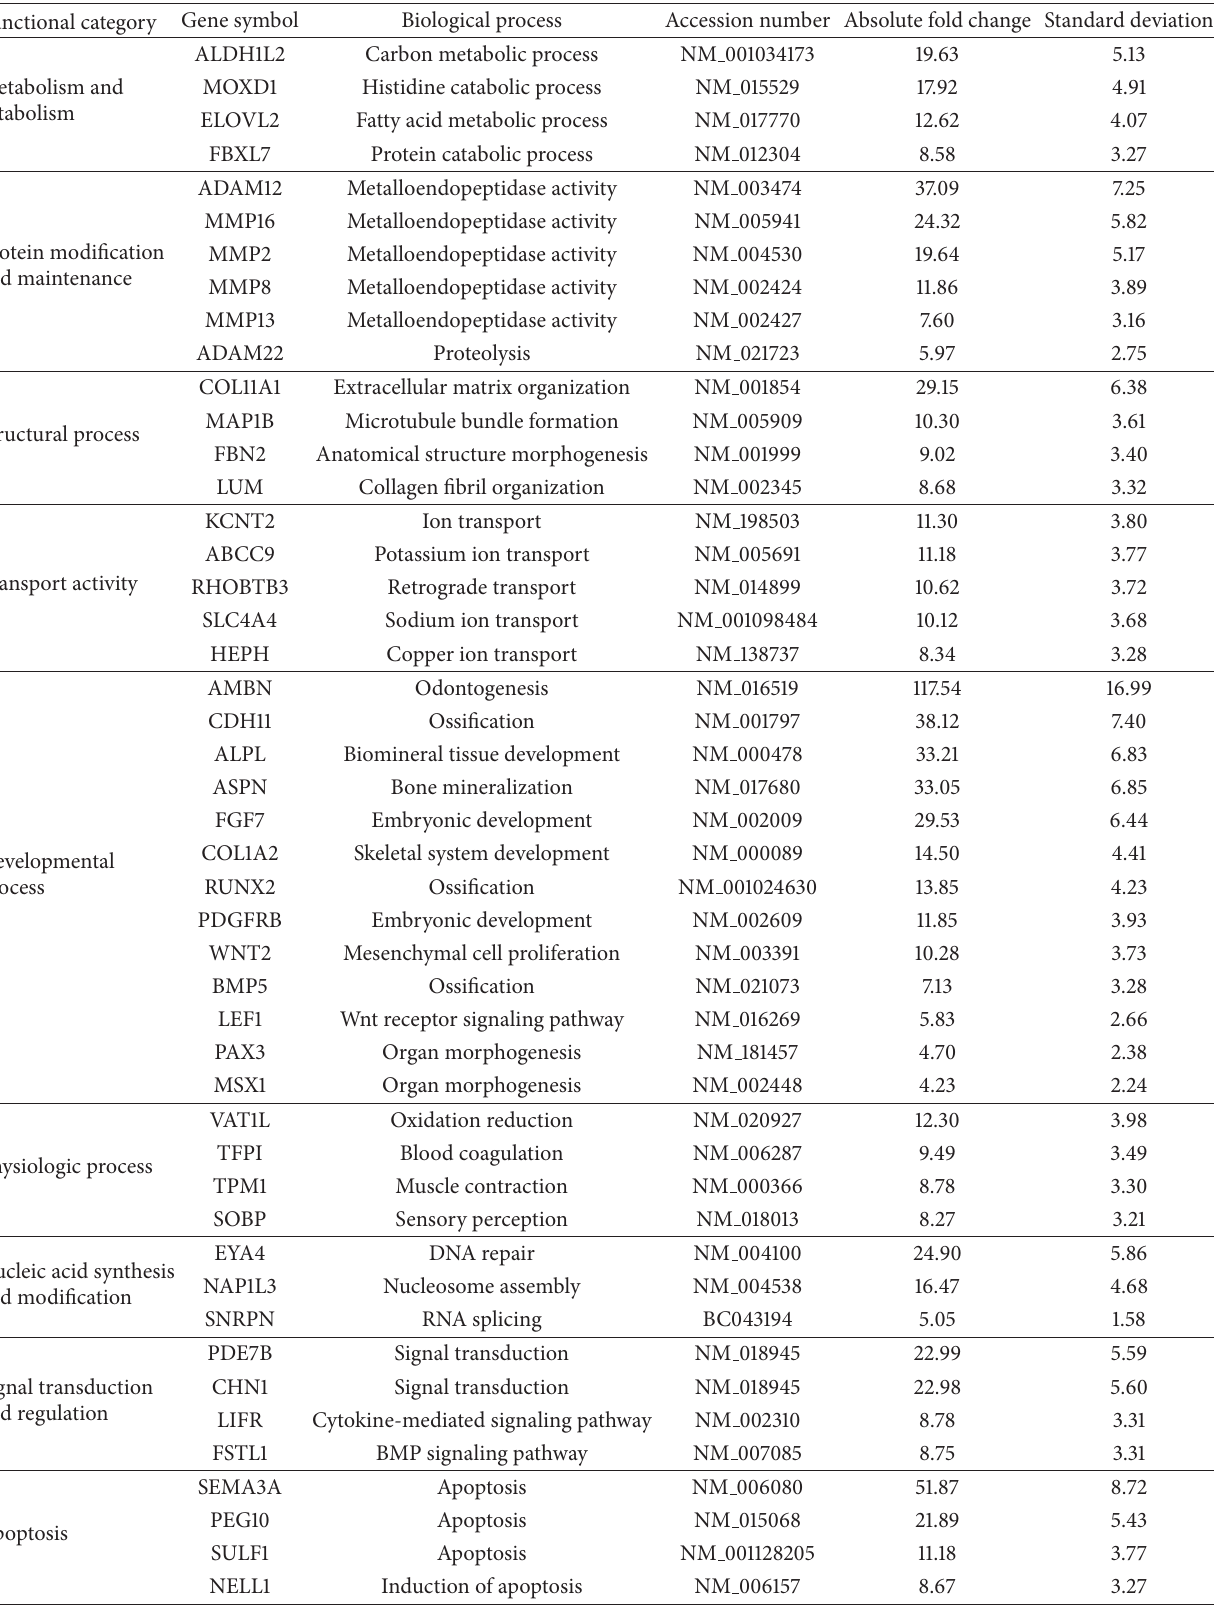
Table 3: Representative genes differentially expressed with higher expression levels in dental follicles than in the gingiva (absolute fold change >